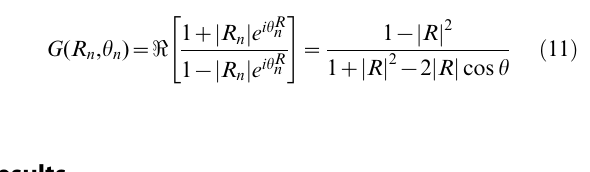
Figure 5. Aortic input impedance. a) Sample impedance modulus (top) and phase (bottom) of three aortas in setup2 computed at CO=5 L/min and HR=72 bpm . b) Sample impedance modulus (top) and phase (bottom) of three aortas in setup1 computed at CO=5L/min and HR=72 bpm . doi:10.1371/journal.pone.0087122.g005 where, for simplicity, we have shown only one harmonic of the series representation for pulsatile power. Table 4. Hemodynamic properties of the aortic simulator.